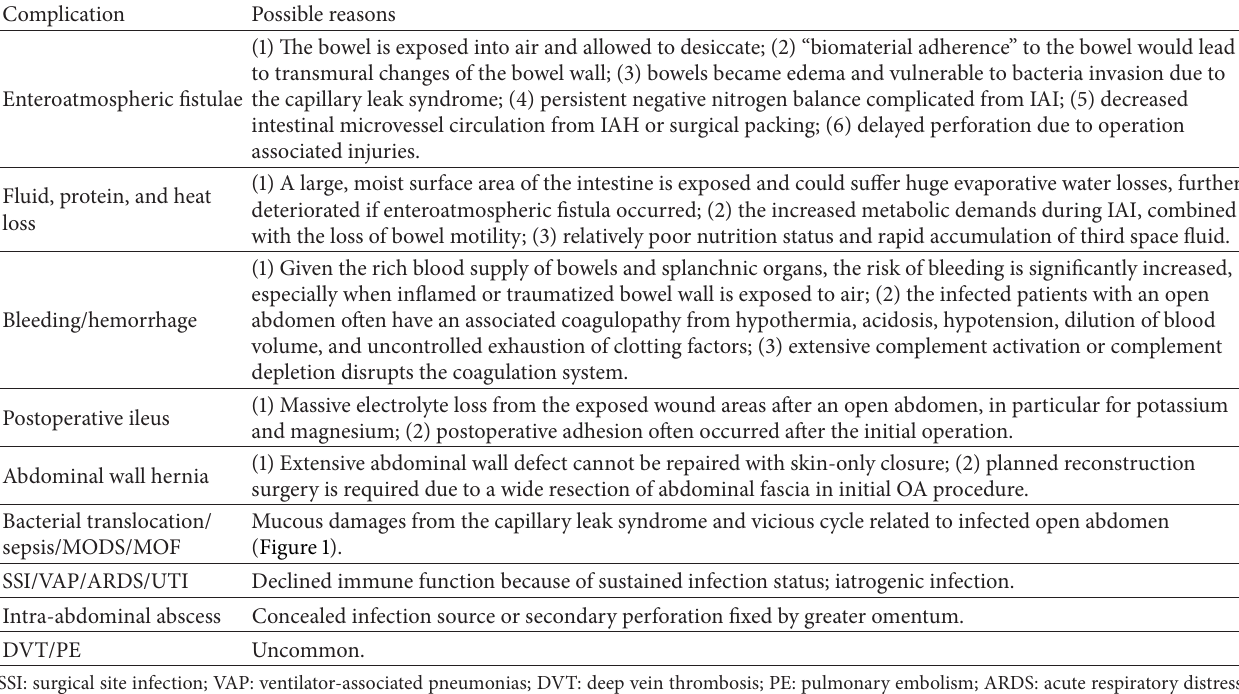
Table 2: Open-abdomen-associated complications in patients with intra-abdominal